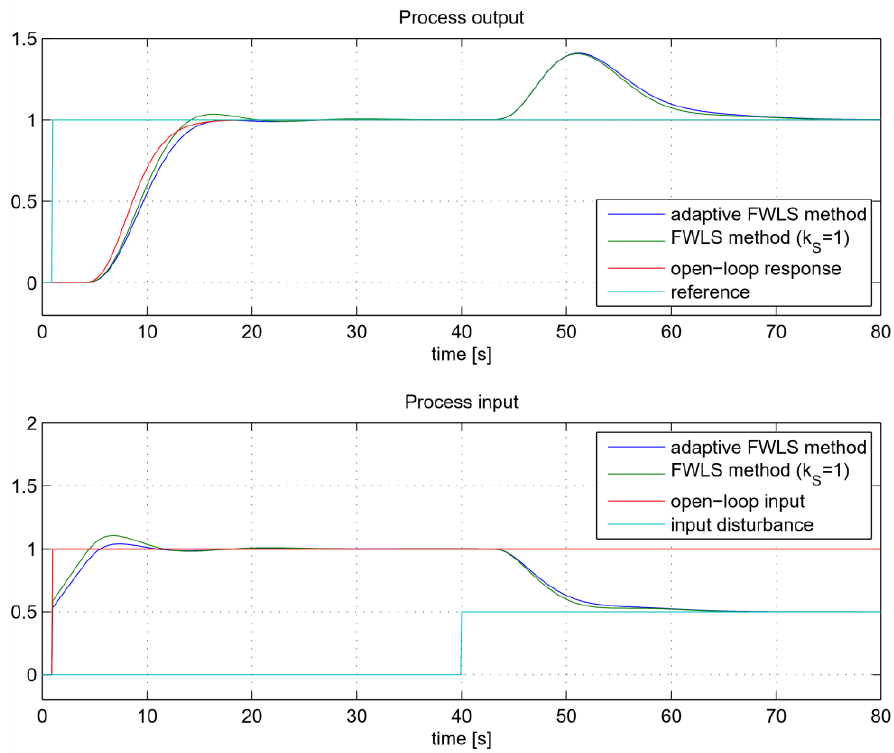
Figure 20. The closed-loop tracking and control signals for process G P 4 .